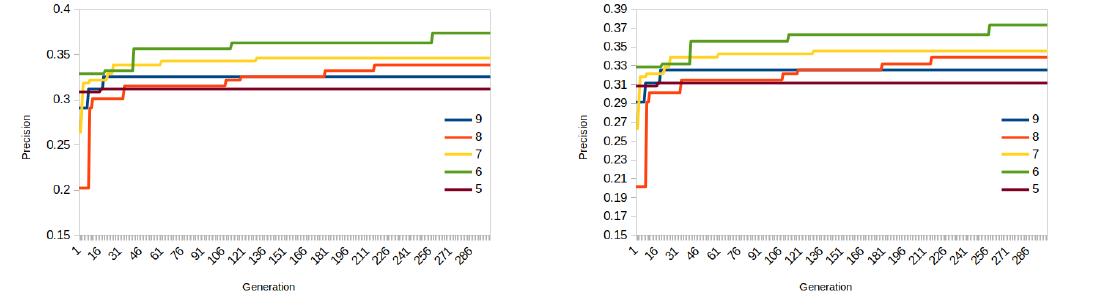
Figure 2. Precision of best individual over generations on ia-radoslaw-email data